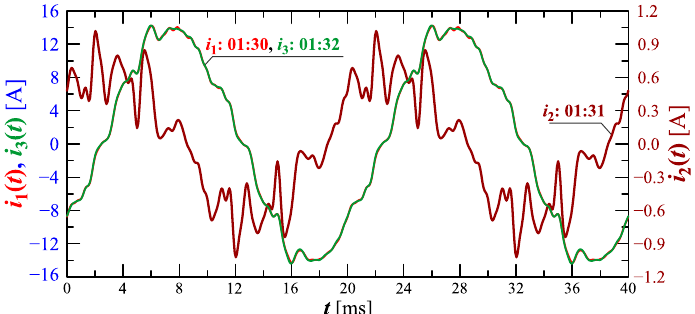
Figure 23. Recreated voltage waveforms u ( t ) and current waveforms i ( t ) recorded at 01:30, 01:31, and 01:32 for Case